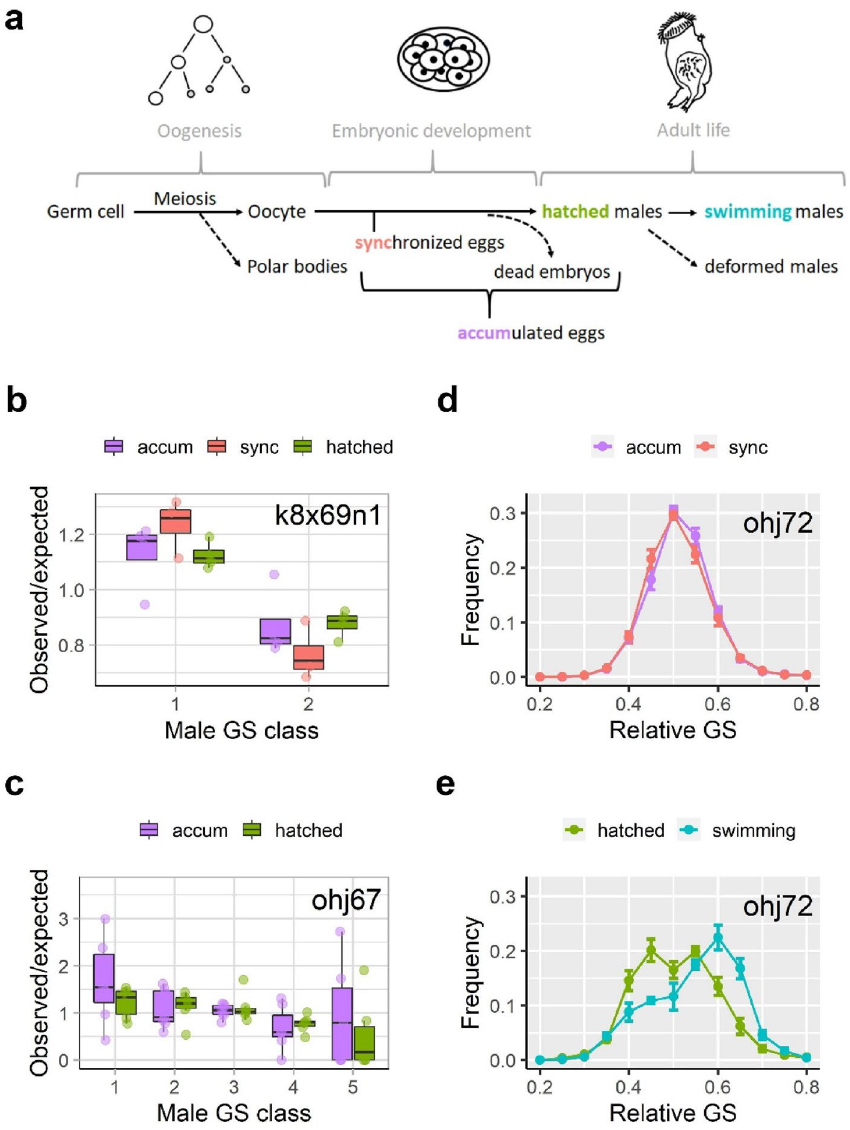
Figure 3. Meiotic transmission biases during different stages of male embryonic development. ( a ) Schematic of male embryonic development and the stages that were distinguished: Synchronized eggs ( sync ) are haploid male eggs with a known age of < 6–8 h, which is shorter than the embryonic development time (~ 20 h). Accumulated eggs ( accum ) are eggs of unknown age sampled from sexual females of a rotifer population, which should contain a larger fraction of dead embryos, compared to sync . Hatched males ( hatched ) are the fraction of embryos that completed development. In one rotifer clone, ohj72, we analyzed an additional category of males ( swimming ) as the fraction of hatchlings that was viable, as opposed to deformed males in the same clone, which were unable to swim properly. ( b ) Analysis of k8x69 (Female GS: 444 Mb), a clone with one ISE and two male genome size classes. ( c ) Analysis of ohj67 (Female GS: 506 Mb), a clone with four ISEs and five male genome size classes. ( d , e ) Analysis of ohj72, a clone with an unknown, but presumably very high number (> 10) of ISEs. In this clone individual male GS classes could not be resolved using flow cytometry. Thus, relative GS instead of discrete GS classes is